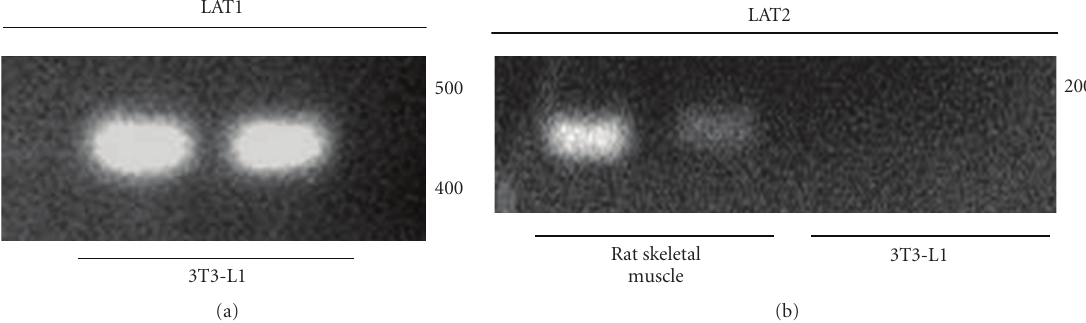
Figure 7: LAT1, a catalytic subunit for System L1 transport, is expressed in 3T3-L1 adipocytes at the mRNA level but LAT2 is not. Reverse transcriptase PCR (RT-PCR) using gene-specific primers designed towards either LAT1 or LAT2 was performed with template cDNA produced from RNA extracted from 3T3-L1 adipocytes. Samples were separated using 2% agarose alongside a 1kb molecular weight marker (Roche Applied Science). (a) LAT1 mRNA is expressed in 3T3-L1 adipocytes. Following agarose gel electrophoresis, a band of 150 bp was observed corresponding to the expected PCR amplicon using LAT1-specific primers as detailed in the text. (b) LAT2 mRNA is not expressed in 3T3-L1 adipocytes. Following agarose gel electrophoresis, no PCR amplicon was detected when 3T3-L1-derived cDNA was used as a template. However, PCR using LAT2-specfic primers and cDNA derived from rat skeletal muscle did amplify a band of the expected size (465bp), as shown, which demonstrates the functionality of the primers